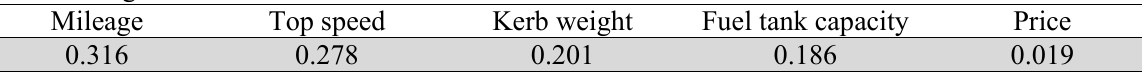
Criteria Weights Mileage